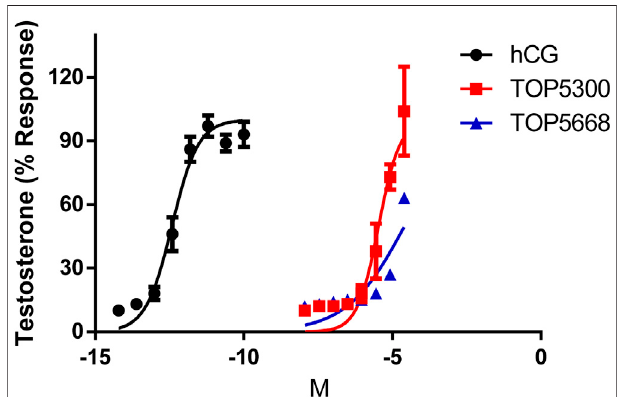
FIGURE 3 | Dose response of hCG, TOP5300 and TOP5668 in rat Leydig cells. Compounds were incubated for 3 h in Leydig cells and testosterone in supernatant measured. Data mean + SD n (cid:1) 3 (for TOP5668, n (cid:1) 1), Triplicate determination in each experiment.